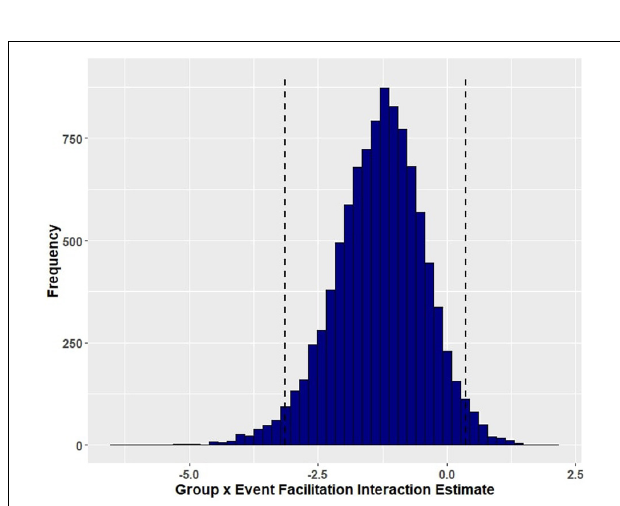
FIGURE 4 | Posterior distribution and 95% highest density intervals (HDIs) of the fixed effect of group from Model 2 (primed response time for participants with aphasia and healthy controls). Dashed lines mark the 95% highest density intervals (HDIs) for the posterior